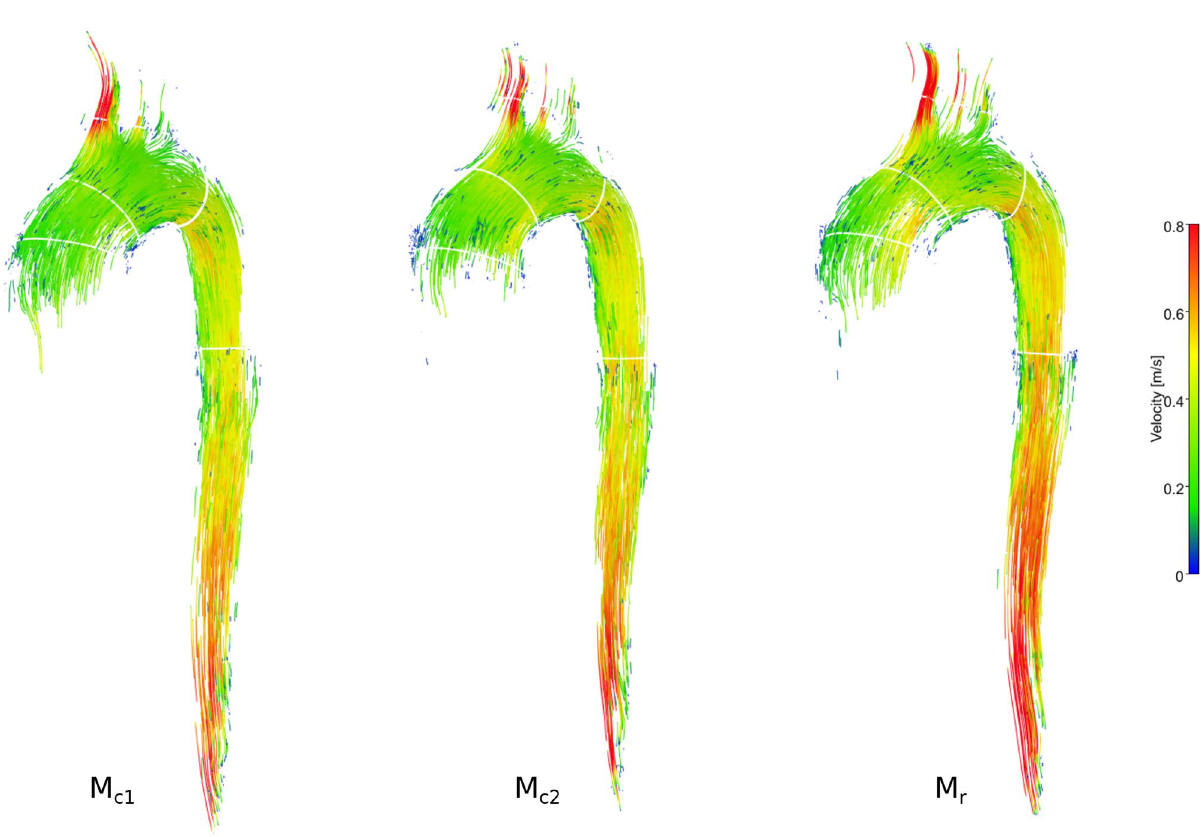
Figure 3. Particle tracing based on 4D-flow MRI data for the three aorta models of identical subject-specific geometry, but different wall stiffness. While particle traces matched among the three models, velocities along the descending aorta—as depicted by the color—were slightly higher in the nearly rigid model M r . An animated version of traced particles is shown in Supplementary Video S3–5. Graphic created using MevisLab (v3.4a, https:// www. mevis lab. Flow at cross-sections. Figure 6 shows flow rate and cumulative net flow results. Results were simi- lar between different models or between 4D-flow data of different temporal sampling rates. Net flow values were 69.6 ± 1.9ml for AAo, 63.4 ± 1.6ml for BCT, 47.0 ± 0.7 ml for LSA, and 45.7 ± 1.0ml for DAo (given as mean ± SD over three models and three temporal sampling rates). Net flow at the landmarks upstream and downstream of the arch branches were within 10% of the programmed pump value (71.2 ml) and the measured ultrasonic value (48.5 ml), respectively. Flow rate waveforms over the cardiac cycle (Fig. 6, solid lines) showed weaker peak flow rate dampening with increased model wall stiffness. This effect was most pronounced at landmarks further downstream (LSA, DAo). 4D-flow sampled at 50 frames per cycle revealed a double flow rate peak in systole at all cross-sections, which was much less apparent in the dataset sampled at 25 frames per cycle and not apparent in the dataset sampled at 16 frames per cycle. Moreover, a distinct second (t = 0.66 s) and third (t = 0.85 ms) flow rate peak were present in all derived waveforms, irrespective of model stiffness and temporal sampling rate. PWV. PWV values were estimated from time-to-foot (TTF) delays of flow rate waveforms at equidistantly spaced cross-sectional planes along the descending aorta (Fig. 7b). Based on the datasets with highest temporal sampling (50 frames/cycle), PWV was 6.98 m/s (LSE) and 5.78 m/s (RANSAC) for model M c1 , and 7.31 m/s (LSE) and 7.31 m/s (RANSAC) for model M c2 . Both for model M c1 and M c2 , PWV values were lower with data- sets sampled at 25 frames/cycle and further decreased for datasets sampled at 16 frames/cycle. The 16 frames/ cycle dataset of model M c1 included four extreme outlier points posting large negative TTF values. These points were excluded prior to fitting the linear model. No linear relationship between TTF and centerline position was detectable for model M r irrespective of temporal resolution. Consequently, while PWV was very high, no PWV values could be reported based on the data.